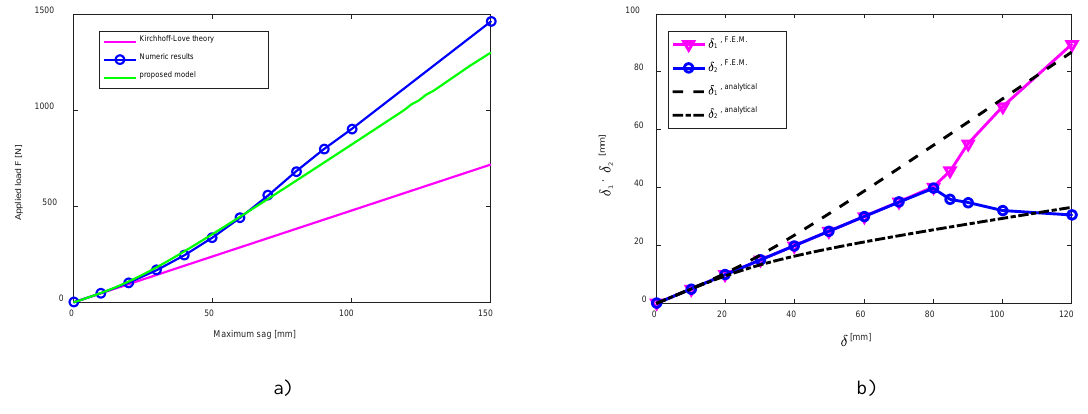
Fig. 3 a) Comparison of the force vs. displacement graphs obtained through the linear analysis (Kirchhoff-Love), the model proposed in (Galuppi et al. , 2014) and the FEM simulations; b) Displacements δ1 and δ2 as functions of δ. Analytical and FEM